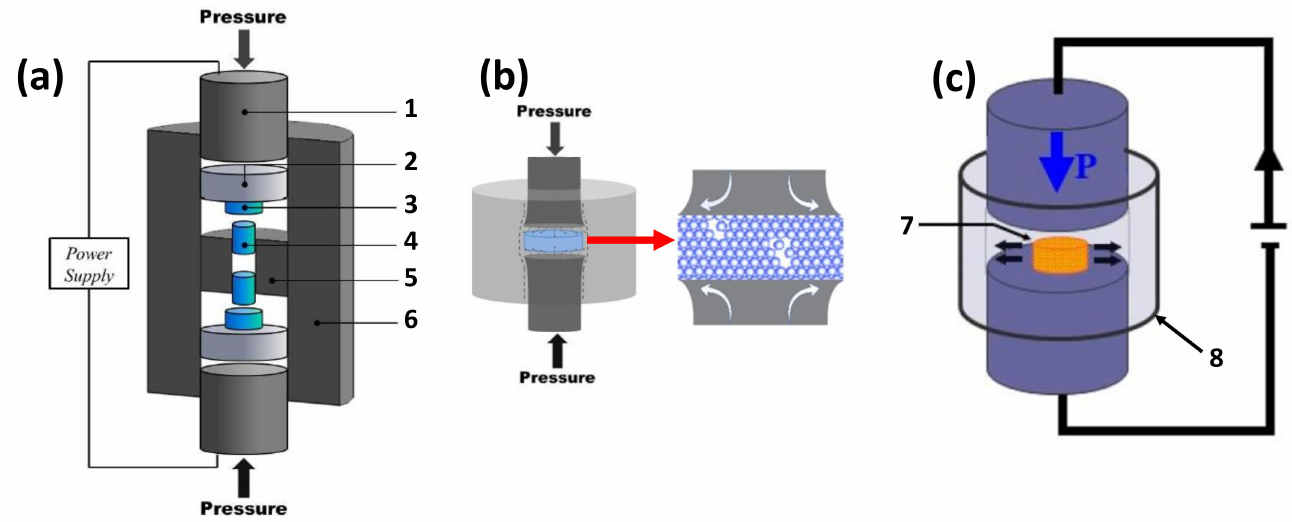
Figure 20. ( a ) DP-SPS configuration. 1. Graphite punch; 2. Silicon carbide space; 3. Tungsten carbide spacer; 4. Tungsten carbide punch; 5. Internal graphite die; 6. Graphite die. ( b ) Schematic of the sample being compressed by tungsten carbide punches inside the graphite die, during sintering. ( c ) Spark plasma texturing (SPT) configuration. 7. Pre-sintered sample; 8. Mold. Adapted from